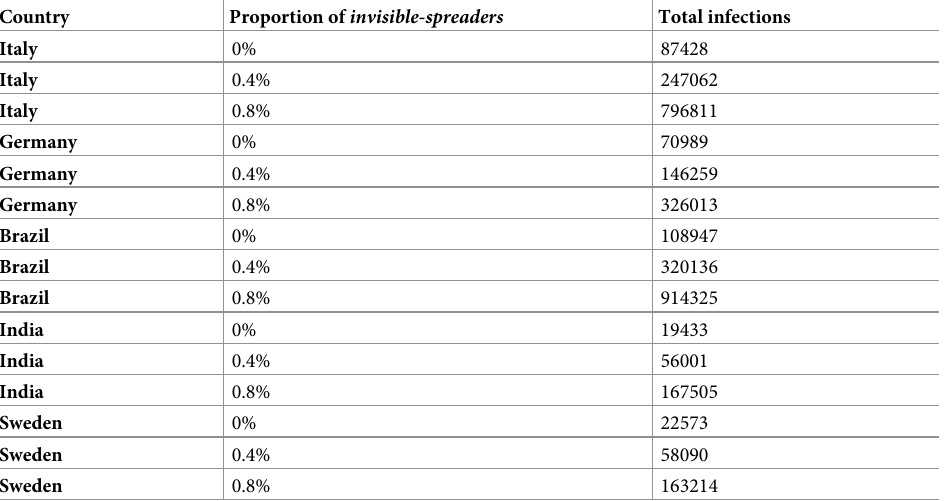
Table 2. Total number of infections in Italy, Germany, Brazil, India, and Sweden under 0%, 0.4%, and 0.8% invisi- ble-spreader proportions up to June 1, 2020.